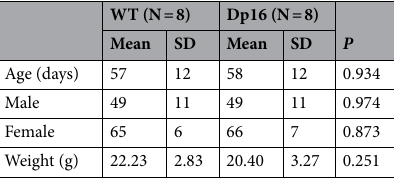
Table 1. Baseline characteristics of WT and Dp16 mice. WT wild-type, Dp16 Dp(16)Yey.